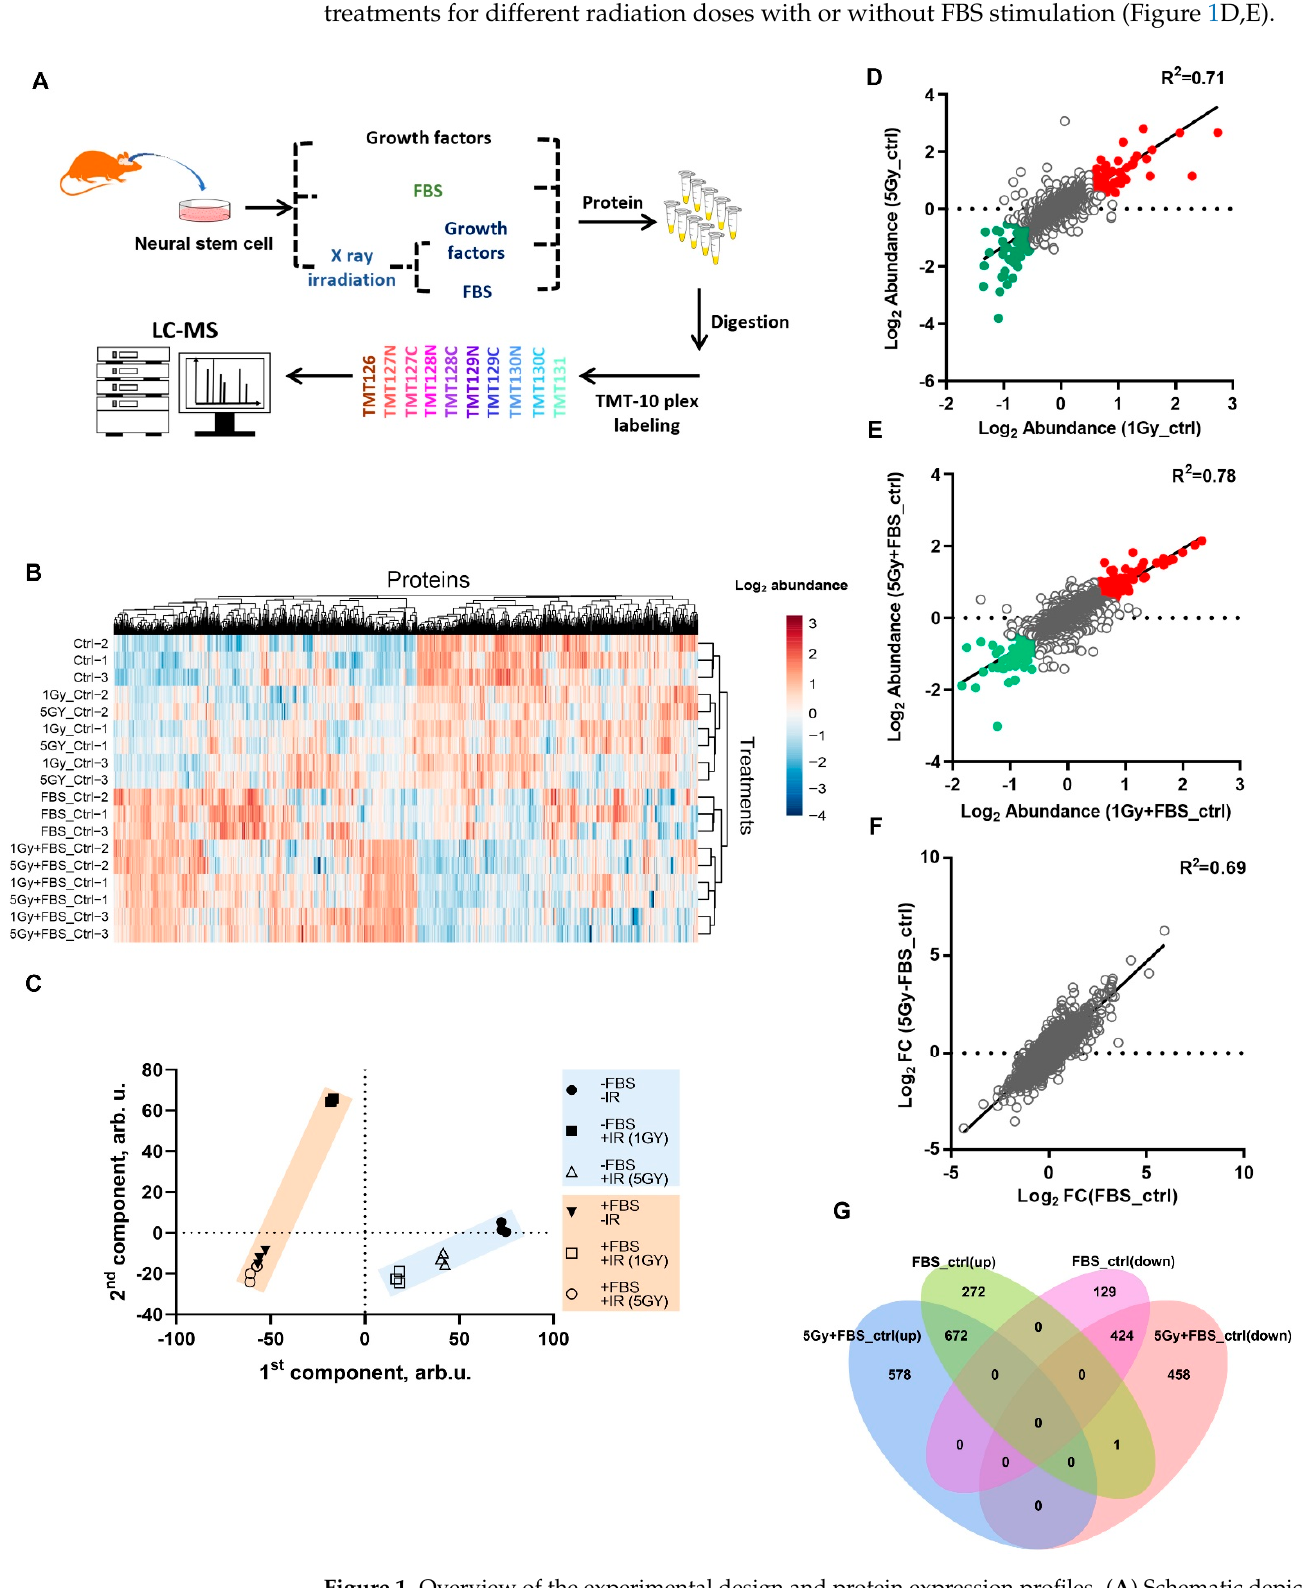
Figure 1. Overview of the experimental design and protein expression profiles. ( A ) Schematic de- piction of experimental grouping and proteomic analysis workflow. ( B ) Heat maps of the differen- tially expressed proteins in each group, the proteomic detections were performed 36 h after each treatment (red, upregulated; blue, downregulated). ( C ) Principal component analysis (PCA) of pro- teomic expression profile among groups; six groups were separated by two main factors: the pres- ence or absence of FBS. “ － FBS － IR” represents the “ctrl” group, “ － FBS + IR” denotes the “1Gy_ctrl or 5Gy_ctrl” group, “ + FBS － IR” represents the “FBS_ctrl” group, and “ + FBS + IR” represents the “1Gy + FBS_ctrl or 5Gy + FBS_ctrl” group. ( D ) Scatter plot of protein abundance correlation between